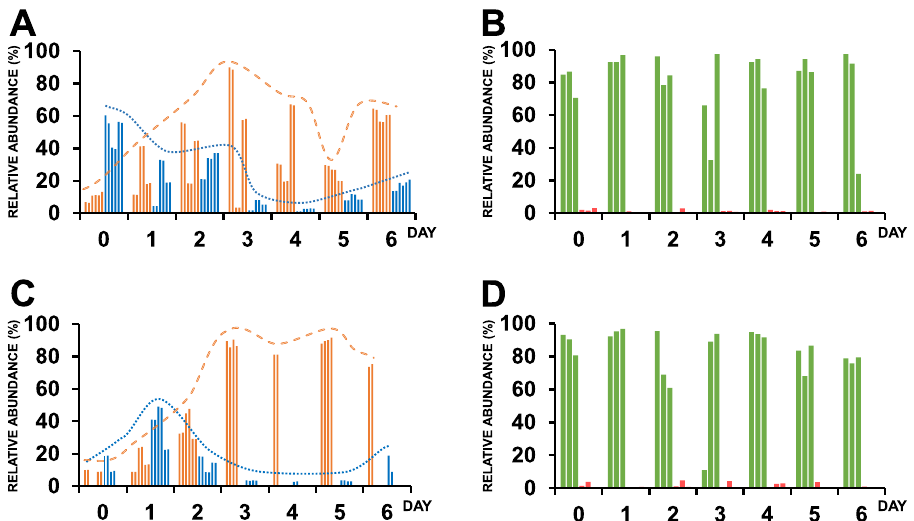
Figure 3. Relative abundance of selected microorganism groups sharing common metabolic and physiological characteristics during the fermentation of fine flavour cocoa beans. Schematic representation of the relative abundance of Acetic Acid Bacteria (orange bars) and Lactic Acid Bacteria (blue bars) and yeasts (green bars) and molds (red bars) identified at Necoclí farm ( A , B : Necoclí farm, C , D : Arauca farm). Orange and blue lines were used to illustrate the behaviour of AAB and LAB over the fermentation, respectively. Each bar represents a replicate. At least two replicates per day were